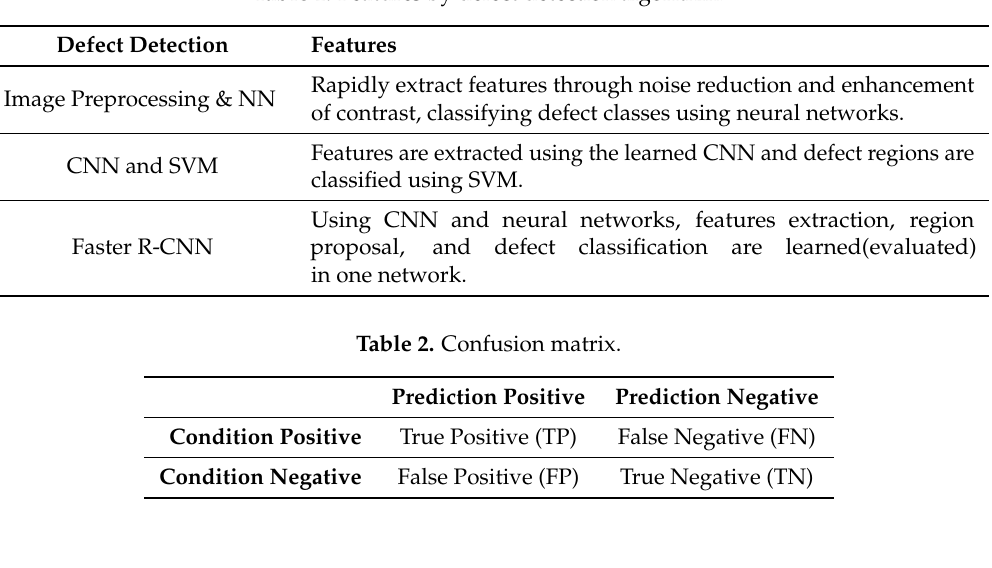
Table 1. Features by defect detection algorithm.